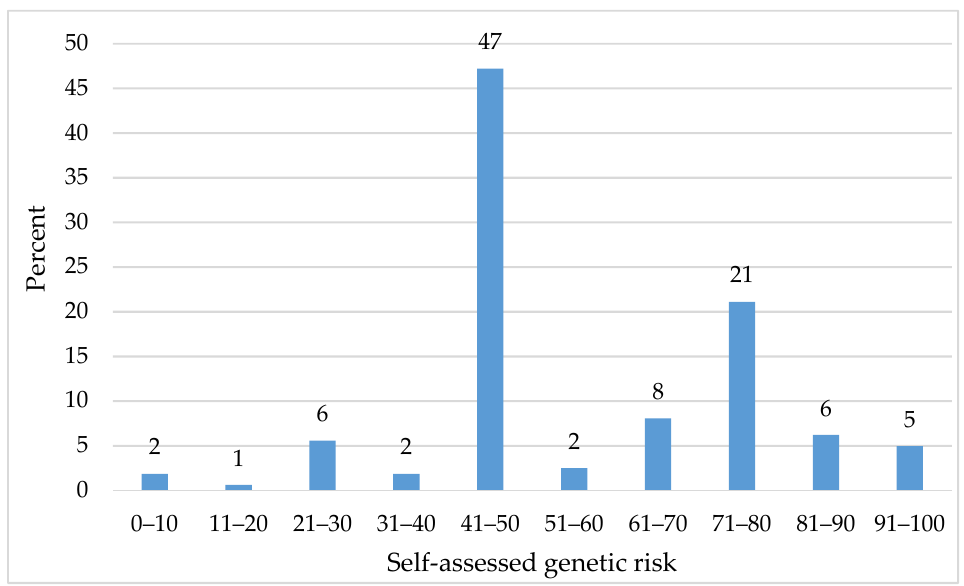
Figure 2. Self-assessed genetic risk of healthy women ( n = 161). Note: The y-axis maximum was truncated.